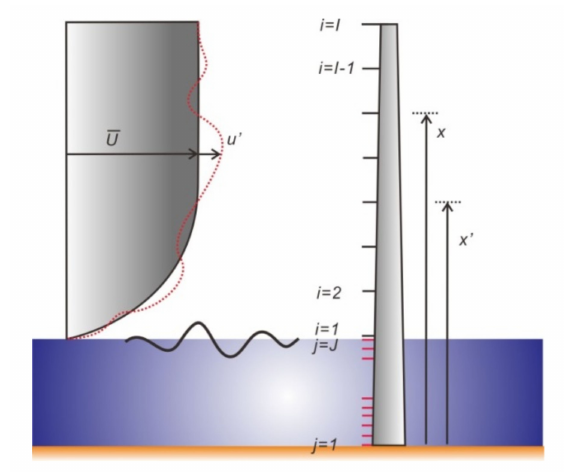
Figure 6. Discretization of the o ff shore wind energy